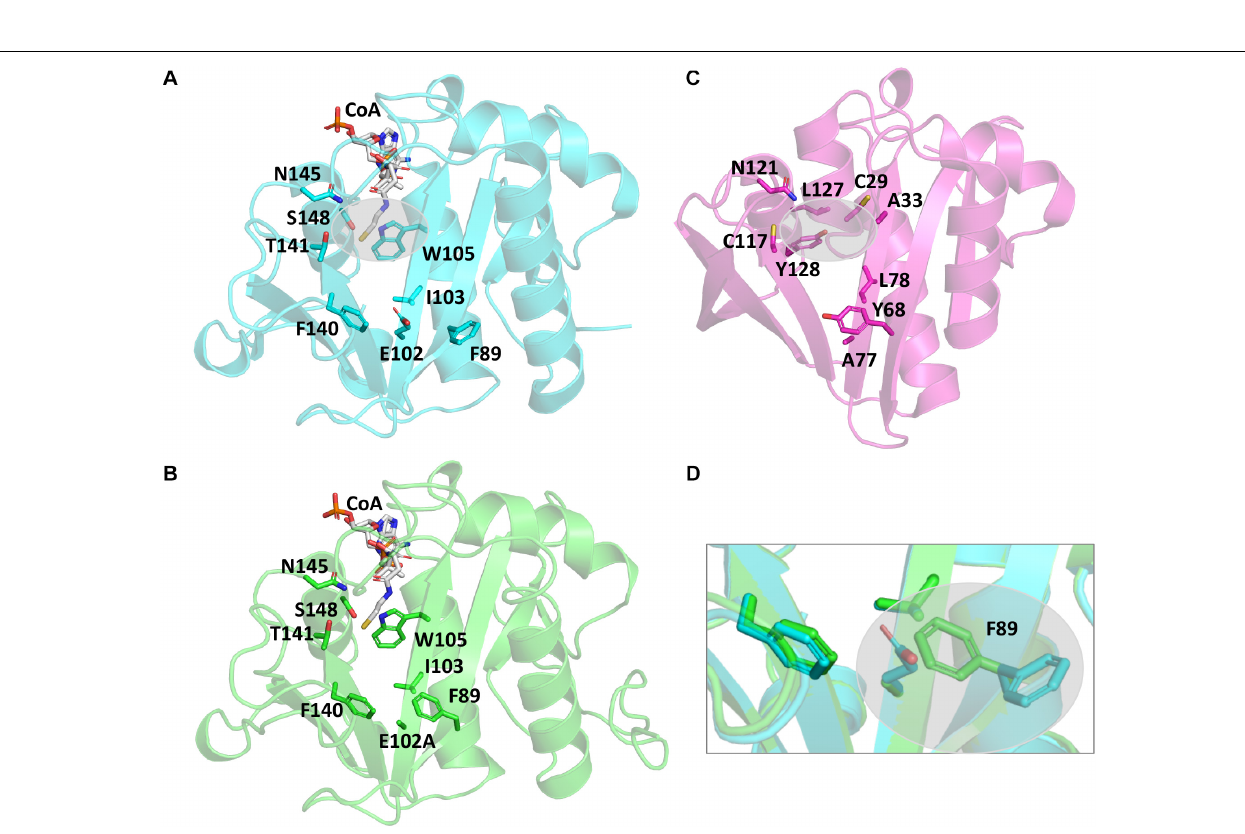
FIGURE 3 | Comparison of PA3944 WT, PA3944 E102A, and PA4794 crystal structures and active sites. (A) WT PA3944 structure (cyan; PDB ID 6EDV). CoA is shown with white sticks and key active site residues are shown with cyan sticks. The gray bubble highlights the region of the active site where a general acid residue would typically be located. (B) WT PA3944 E102A crystal structure (green; PDB ID 7KPP). CoA is shown with white sticks and key active site residues are shown with green sticks. (C) PA4794 crystal structure (pink; PDB ID 5VDB). The ligand was removed for clarity and key active site residues are shown with pink sticks. The gray bubble highlights the region of the active site where a general acid residue would typically be located. (D) Overlay of PA3944 WT and E102A structures. The box highlights the F89 residue, which changes conformation when E102 is mutated to alanine. Figures were made using Pymol.